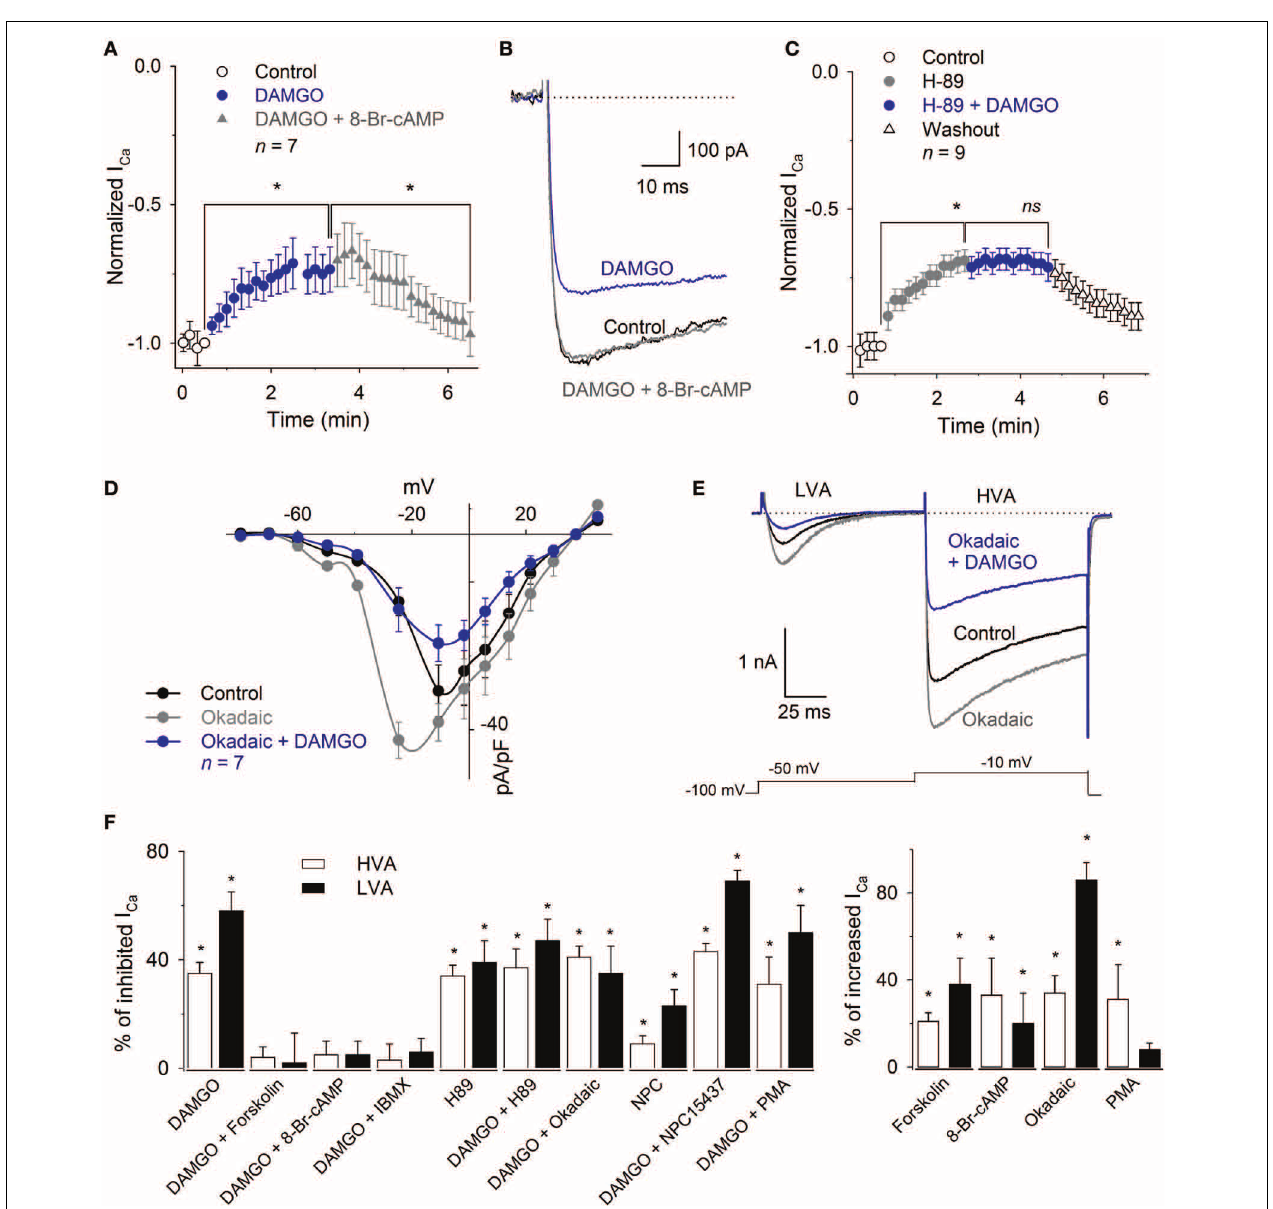
FIGURE 7 | Inhibition of the I Ca by MOR activation was reverted by 8-Br-cAMP or IBMX and mimicked by H89. (A) Time course of the I Ca amplitude under the control condition, after 1 μ M DAMGO and DAMGO plus 1mM 8-Br-cAMP application. The application of 8-Br-cAMP reverted the DAMGO inhibition 92 ± 7% ( n = 7). (B) Traces of the I Ca under the control condition, after DAMGO and after the co-application of DAMGO and 8-Br-cAMP. (C) Time course of the I Ca peak amplitude under the control condition, after the use of 1 μ M H89 and after 1 μ M H89 plus 1 μ M DAMGO perfusion. The H89 mimicked the inhibitory effect of DAMGO; the co-application of H89 and DAMGO did not add to its inhibitory effects ( n = 9). (D) I-V relationship of calcium current showed that the phosphatase inhibition